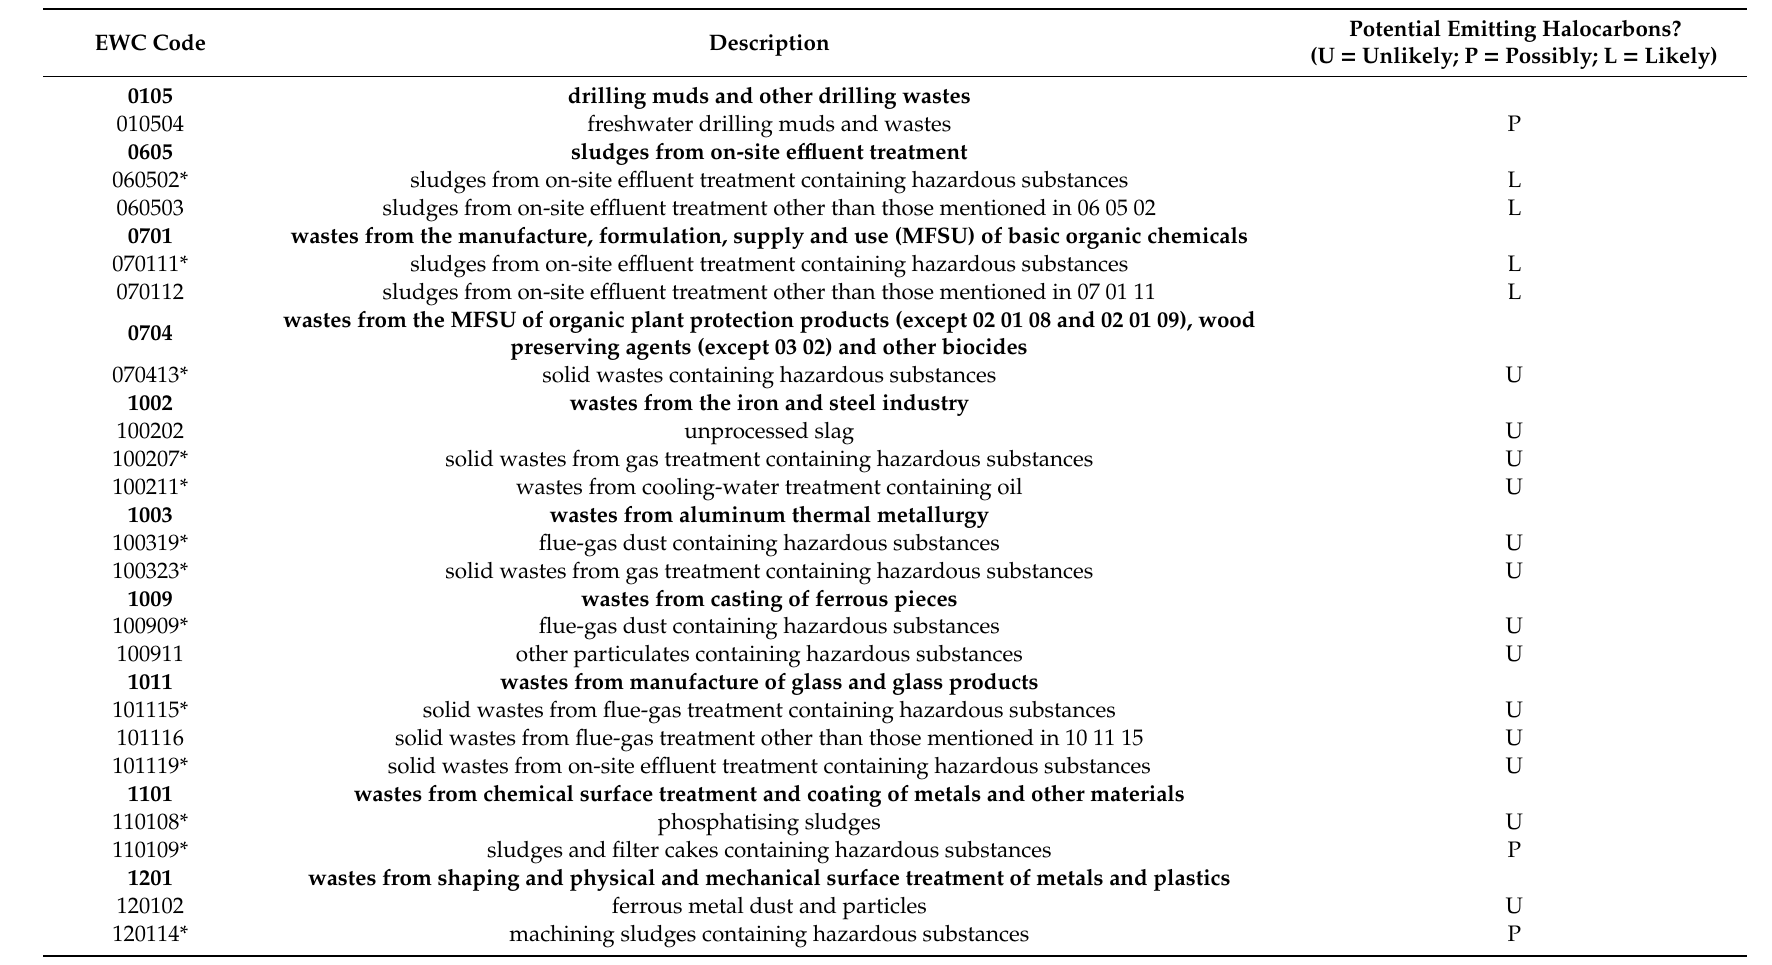
Table A1. List of waste typologies constituting the code